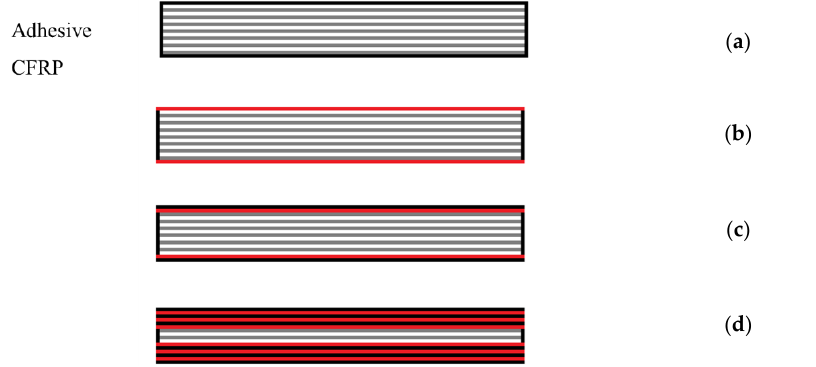
Figure 25. Schematic design of ( a ) CFRP, ( b ) a single external adhesive layer, ( c ) a single interlaminar adhesive layer, and ( d ) three interlaminar adhesive layers. Adapted from [156,160]. Morgado et al. [160] evaluated the use of a single interlaminar adhesive layer, three